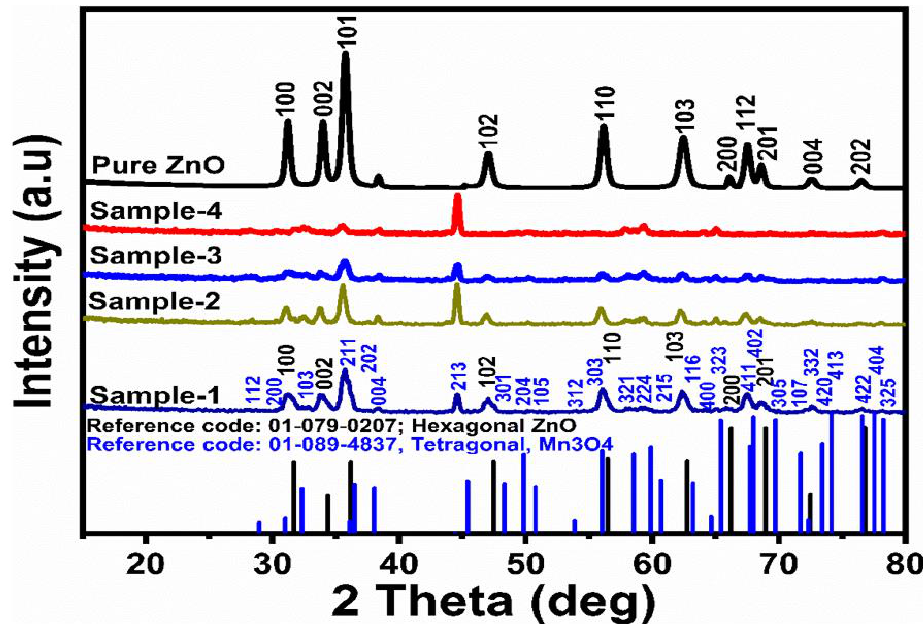
Figure 1. XRD patterns of pristine ZnO and Mn 3 O 4 @ZnO hybrids with different amounts of Mn 3 O 4 .